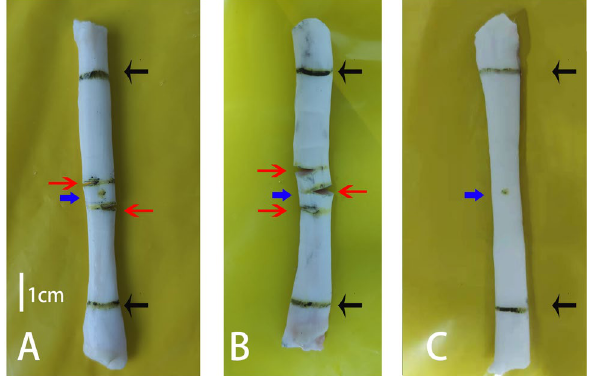
Figure 1. The model of tendon hemisection. ( A ) double hemisection tendon, ( B ) triple hemisection tendon, and ( C ) complete tendon. The distance between hemisections in A and B was 0.5 cm. The length of the test area of the tendons ( distance between the two clamp lines) was 6 cm. The central point, clamping line, and hemisection planes of the tendon are marked (indicated by blue, black, and red arrows, respectively). On the tendons with hemisections, incisions were cut to half or more of the cross-sectional area of the tendon. The central point and clamp lines are marked on the intact